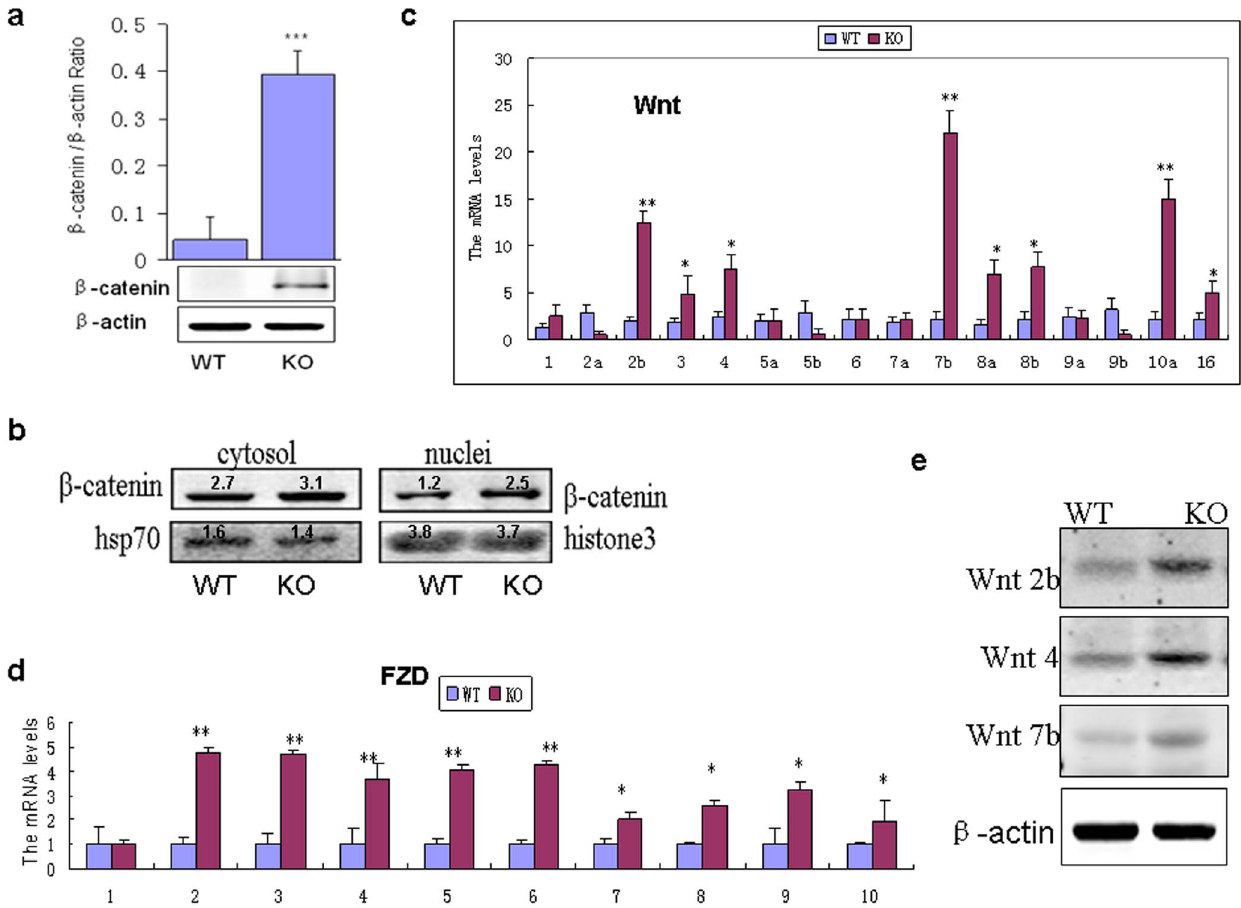
Figure 6. b -catenin/Wnt signaling was activated in the kidneys of Gpr48 2 / 2 mice. (a) The expression of b -catenin was analyzed by Western blot. (b) Western analyses of b -catenin in cytolosic and nuclear fractions in the kidney cells of Gpr48 KO and WT mice. (c)RT-PCR results showed the expressions of different Wnt genes in the kidneys of Gpr48 KO and WT adult mice. (d) The expressions of different Fzd genes were evaluated by RT- PCR in the kidneys of Gpr48 KO and WT adult mice. (e) Western blot analysis shows the dramatic increases of Wnt2b, Wnt4b and Wnt7 in Gpr48 KO mice. All data are expressed as Mean 6 SD, n=15. ***p , 0.001, ** p , 0.01,*p , 0.05, KO vs WT.